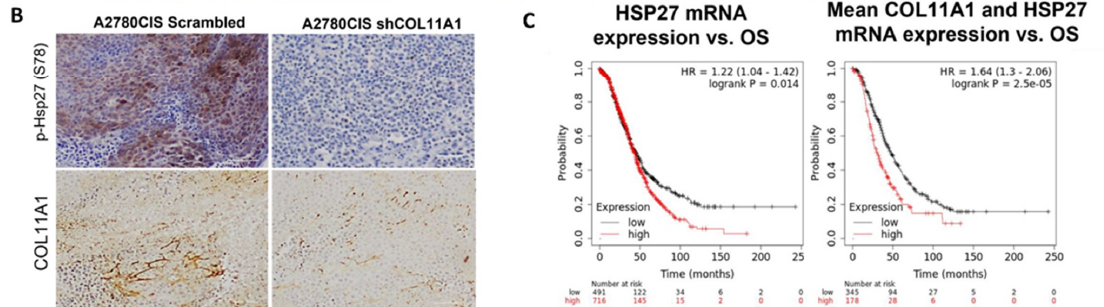
Figure 5. HSP27 expression and phosphorylation is upregulated in vivo in tumor xenografts and in ovarian cancer patients. ( A ) Representative immunofluorescence images of total and p-HSP27 (S78 and 82) in xenograft tumors generated from A2780/vehicle-injected mice and A2780/COL11A1-injected mice. Green: HSP27 (total and phospho); blue: DAPI. Scale bars: 330 µm (10×) and 165 µm (20×). ( B ) Representative images of IHC staining of p-HSP27 (S78) and COL11A1 in A2780CIS-scrm and A2780-shCOL11A1 tumors. Scale bar: 100 µm. ( C ) Overall survival in patients expressing high levels of HSP27 mRNA compared to the low-expressing group (left). Overall survival in patients expressing high mean expression of COL11A1 and HSP27 mRNAs compared to the low-expressing group (right).